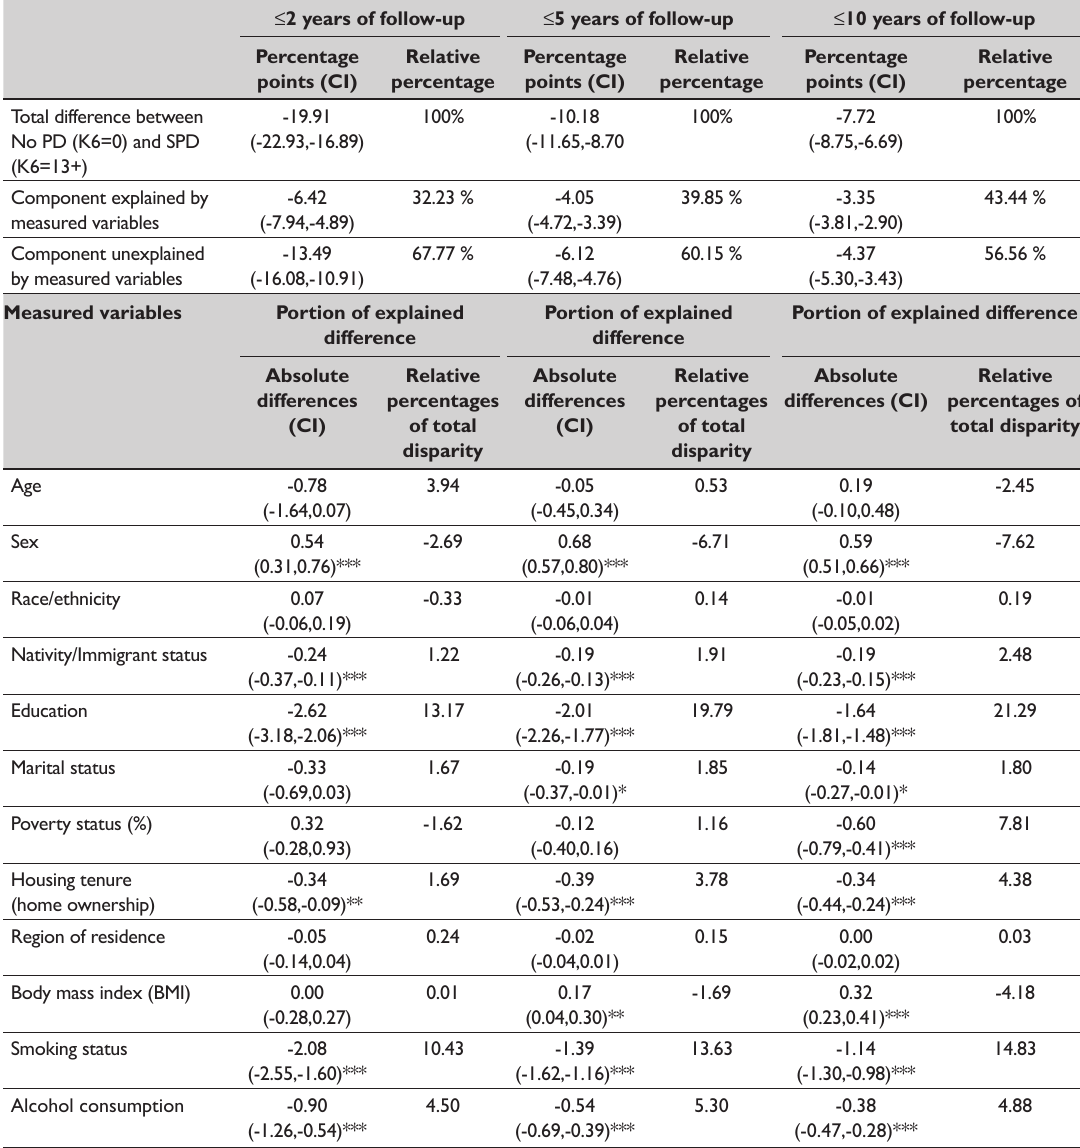
Table 4: Blinder-Oaxaca linear decomposition results for disparities in all-cause mortality between adults without psychological distress (PD) and with serious psychological distress (SPD) by follow-up years 1 ,